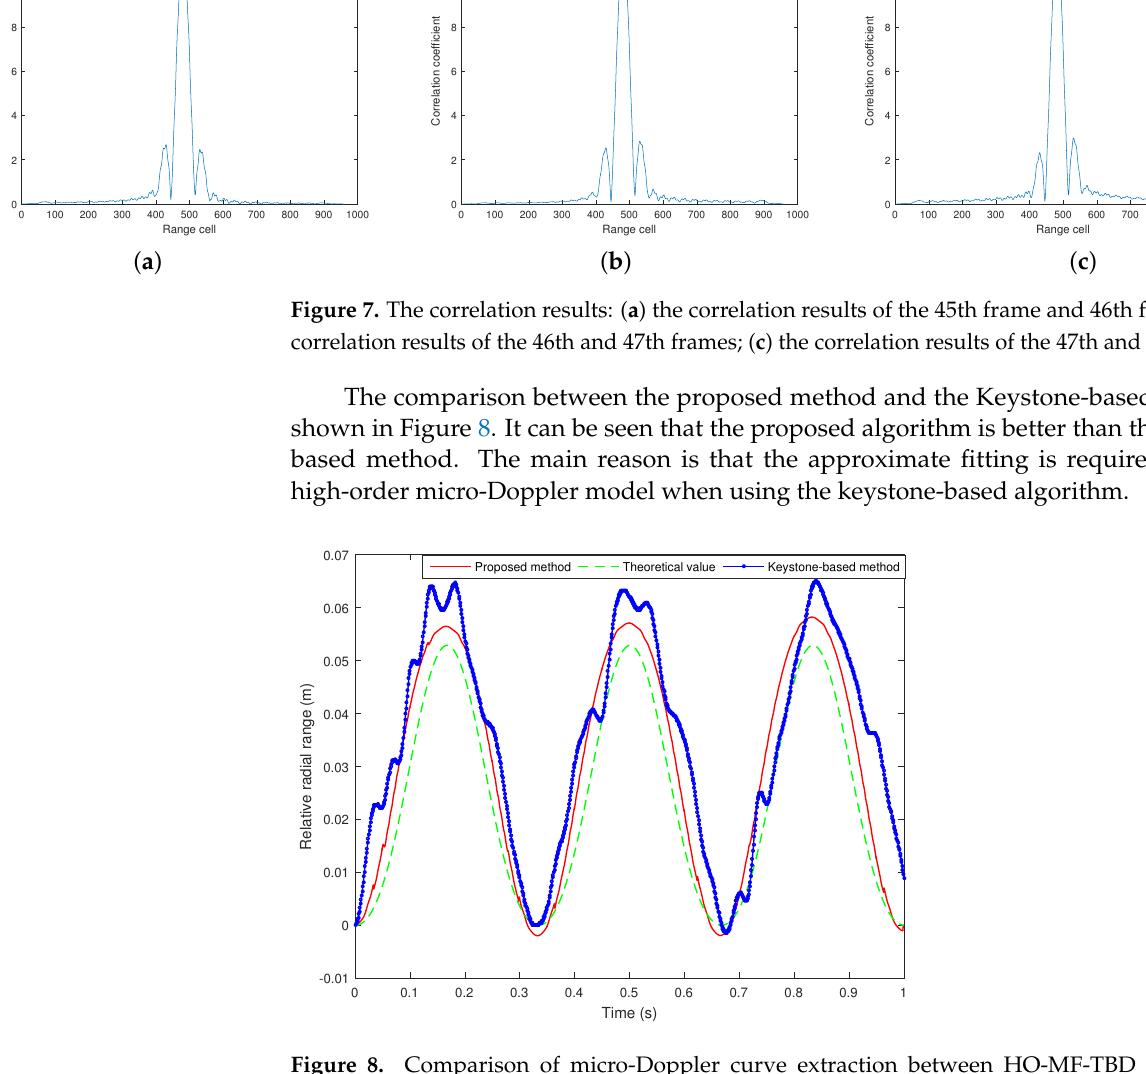
Figure 8. Comparison of micro-Doppler curve extraction between HO-MF-TBD method and keystone